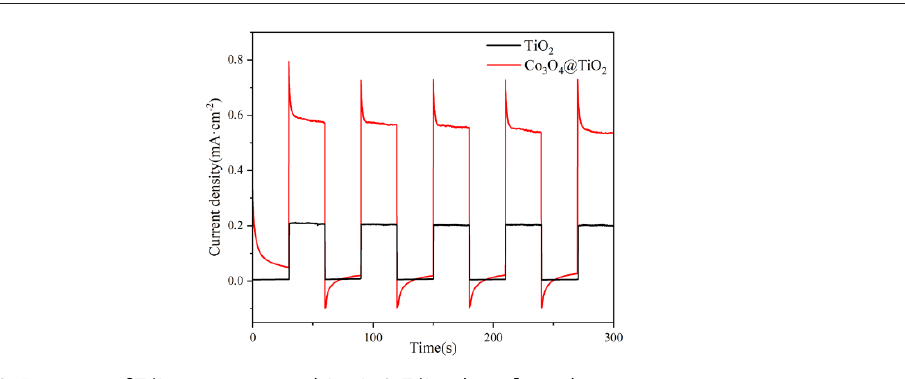
Fig. 3. I-t curves of TiO 2 nanocones and Co 3 O 4 @TiO 2 photoelectrode.